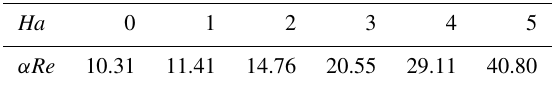
Table 3. The α Re values for some Hartmann numbers ( Ha ) at the separation